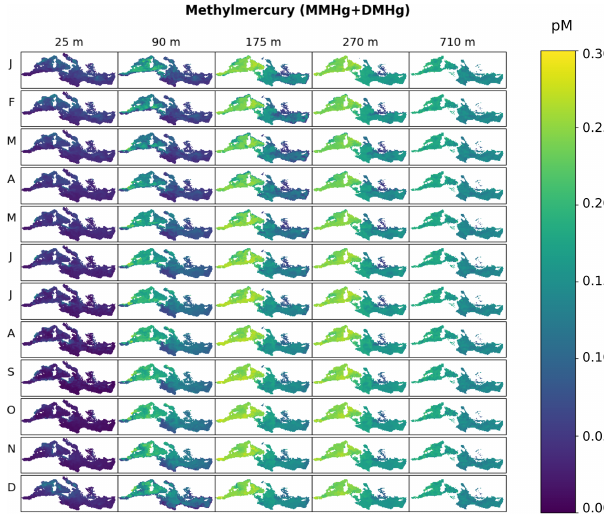
Figure 4. Spatial distribution of monthly averaged MeHg concen- trations (pM) in the Mediterranean Sea at different depths in the water column (25, 90, 175, 270, and 710m depth) simulated with the OGSTM–BFM–Hg model.